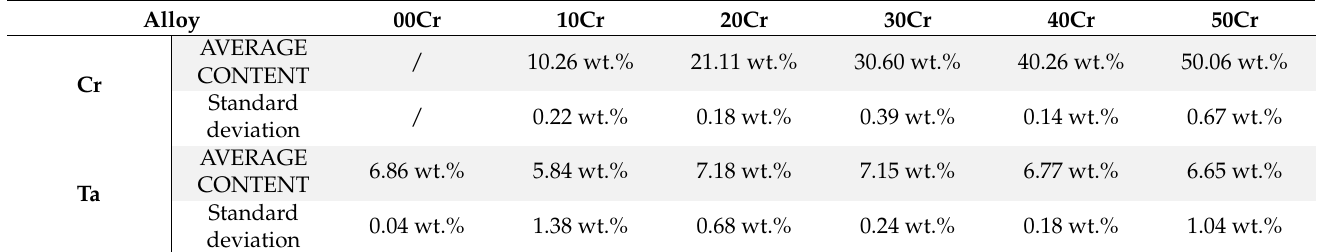
Table 2. The chemical compositions of the obtained alloys (several × 250 full-frame EDS analyses).